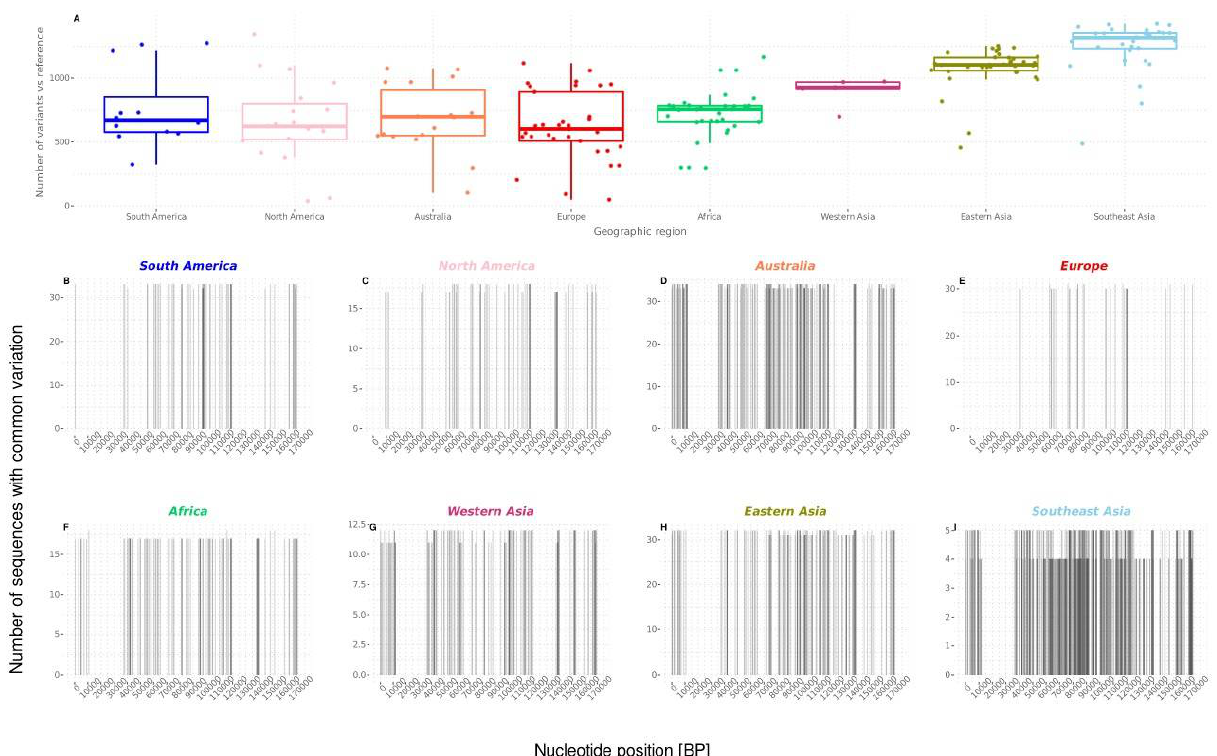
Figure 3. Quantification of EBV1 genomic variation regarding geographic origin: ( A ) quantification and comparison of the amounts of variants from different regions, with the results depicted in box plots; ( B – I ) positioning of common variants against the EBV1 reference along the genome for each geographical region.